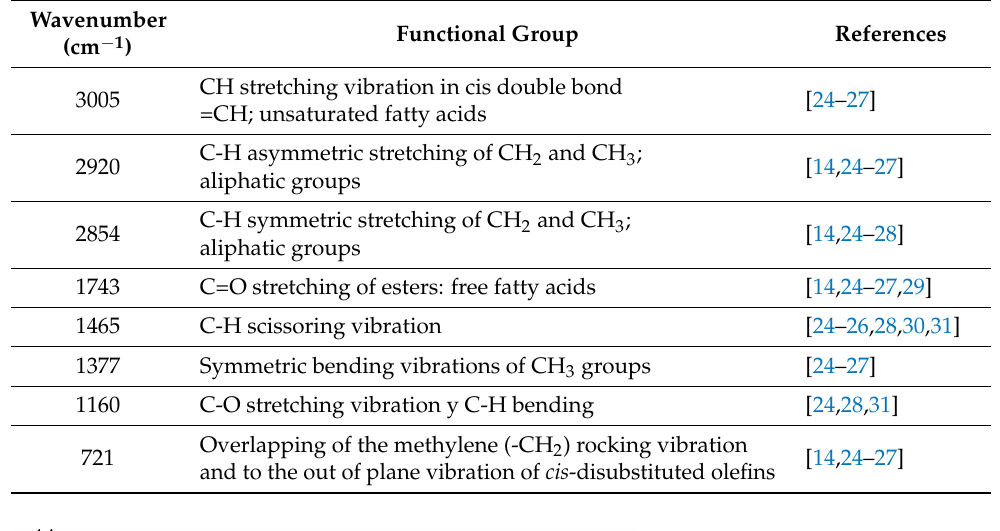
Table 1. Wavenumber assignment with the chemical functional groups.